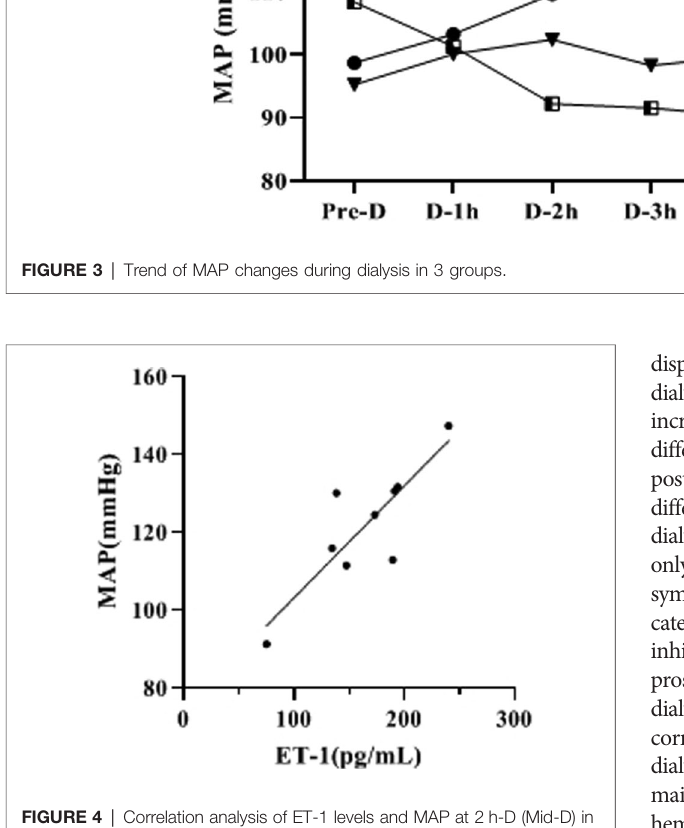
FIGURE 4 | Correlation analysis of ET-1 levels and MAP at 2 h-D (Mid-D) in group